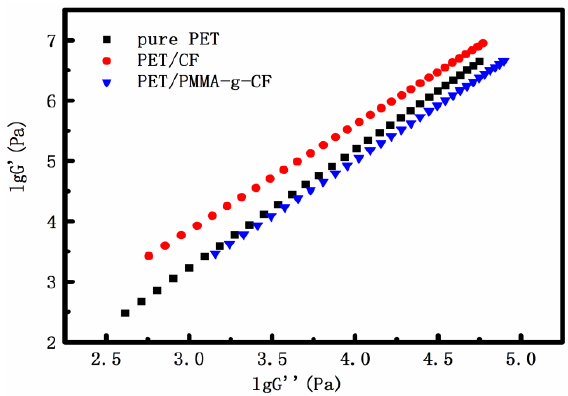
Figure 7. Cole-Cole plot of pure PET, PET/CF, and PET/PMMA-g-CF composites.